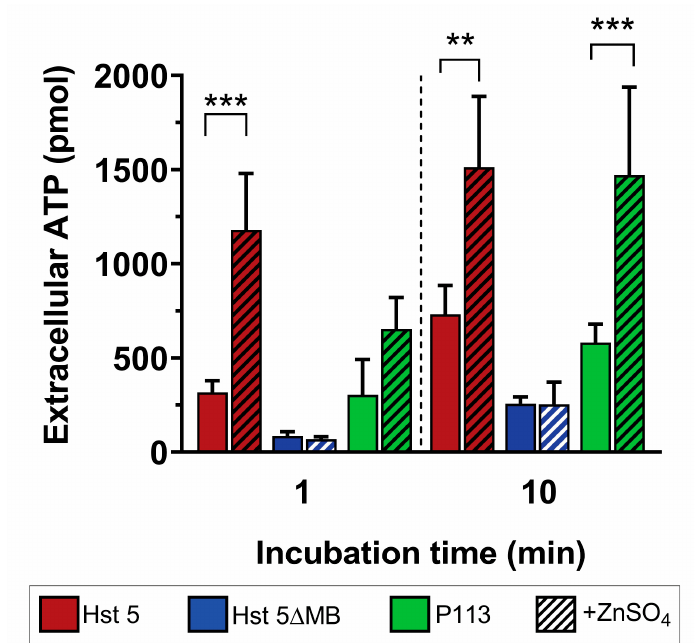
Figure 5. Zinc induces almost immediate ATP efflux. C. albicans SC5314 bioluminescent ATP efflux assay. Cells were treated at 30 °C with 0.88 fmol/ cell. Hst 5 (red), Hst 5 Δ MB (blue), or P113 (green) in 10 mM sodium phosphate buffer pH 7.4 with or without added Zn 2+ at a one to two peptides ratio (hatched). Cells were removed from samples via centrifugation and aliquots of supernatant were taken at 1 min and 10 min time points to measure extracellular ATP by luminescence. Experiments were repeated on at least three separate days and averaged. Significance of differences in ATP efflux calculated using one way ANOVA with Sidak’s multiple comparison test. ** indicates p ≤ 0.01, *** indicates p ≤ 0.001.